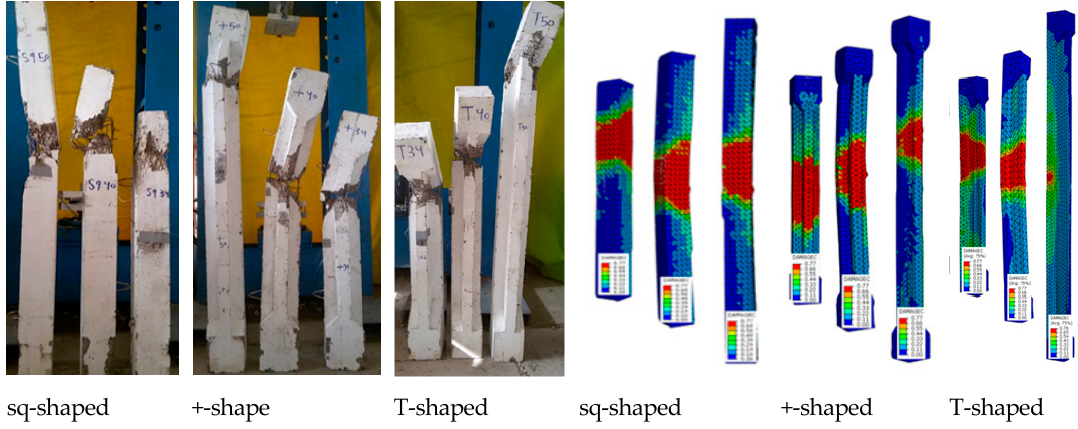
Figure 5. Results of the experimental test and finite element analysis. Table 2. Results of the experimental test and finite element analysis.